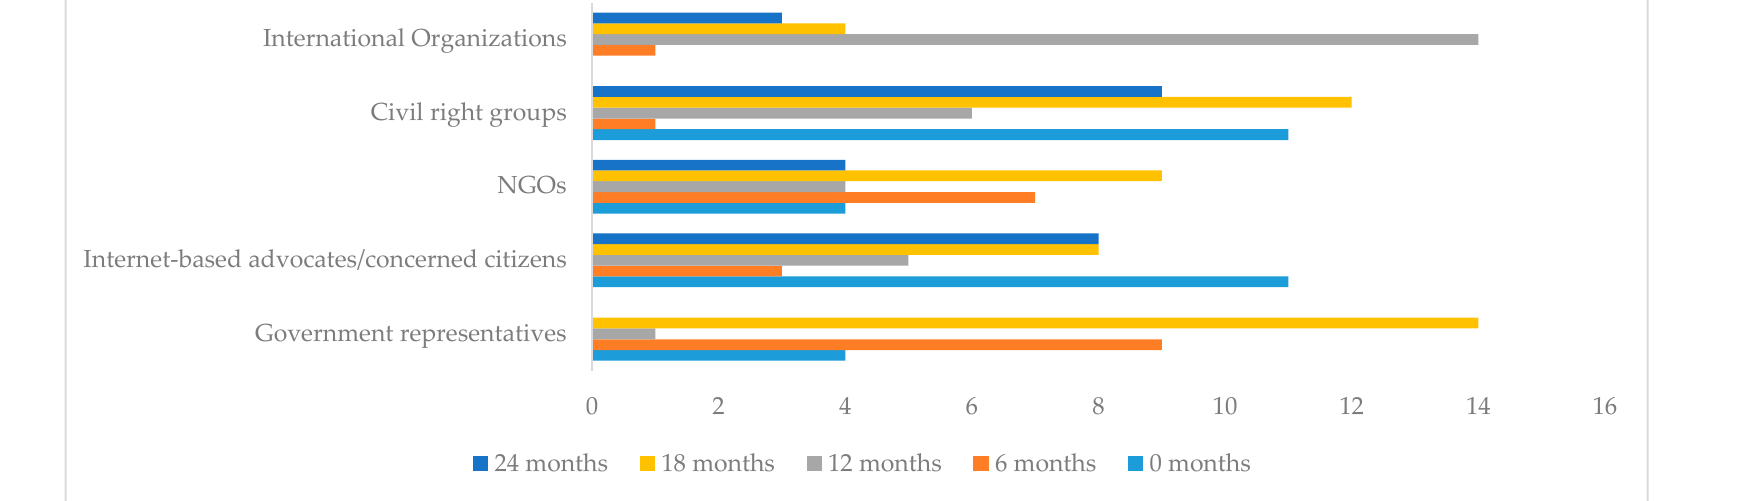
Figure A2. Distribution of respondents in Benin.